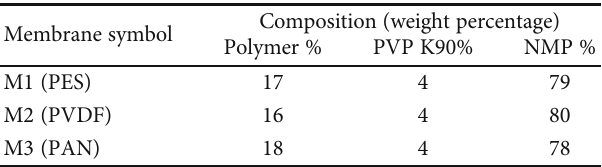
Figure 2: Preparation steps for PVP blend membrane. Table 1: Polymeric solution composition for PVP-polymer blends